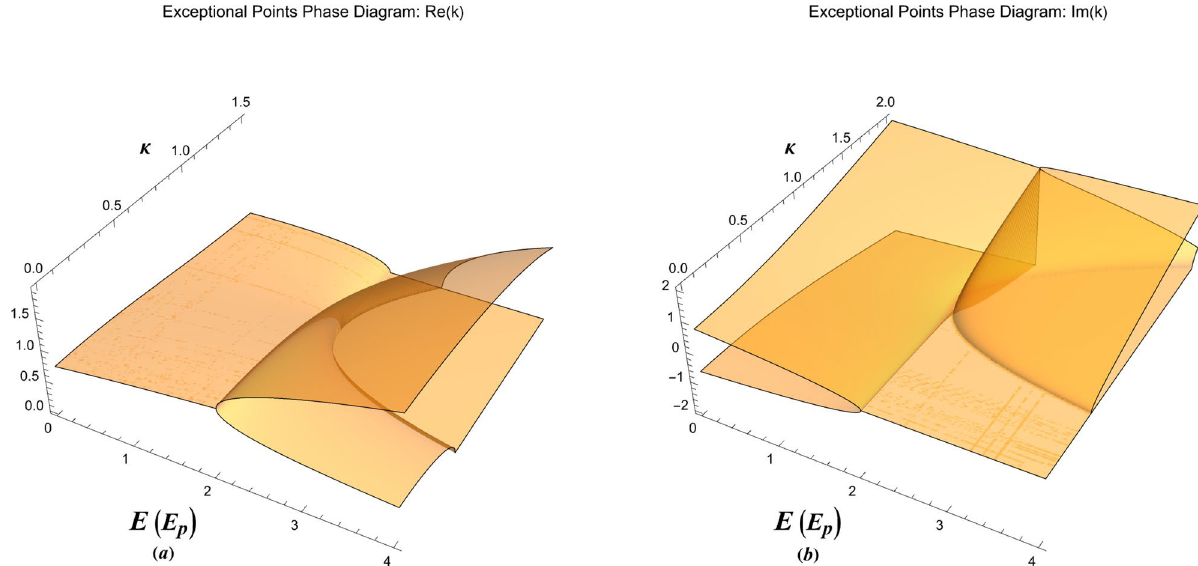
Figure 3. The exceptional point phase diagram of damped oscillations showing ( a ) the real part and ( b ) the imaginary part of the collective oscillation wavenumber in E - κ